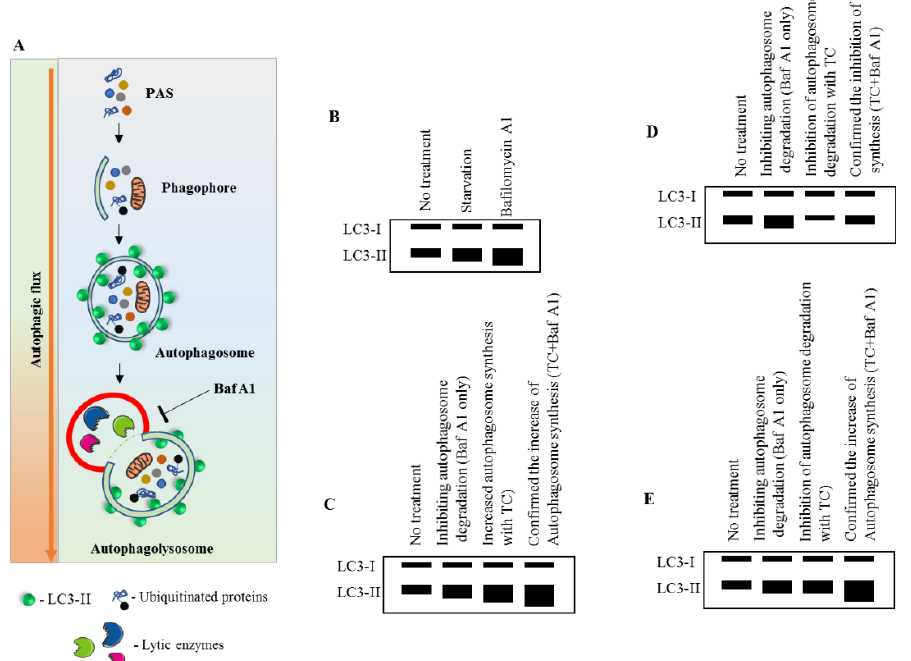
Figure 2. Immunoblot measurement of MAP1LC3B turnover and its dynamics. ( A ) Pictorial representation of the autophagic flux process. Baf A1 inhibits the autophagy process by blocking the autophagosome – lysosomal fusion. ( B – E ) Effect of a test compound on MAP1LC3-II expression. Without the use of Baf A1, it would be unpredictable to assess whether the compound is increasing the autophagosome synthesis or inhibiting the autophagosome degradation. Modified from [59]. See abbreviations in the abbreviations section.